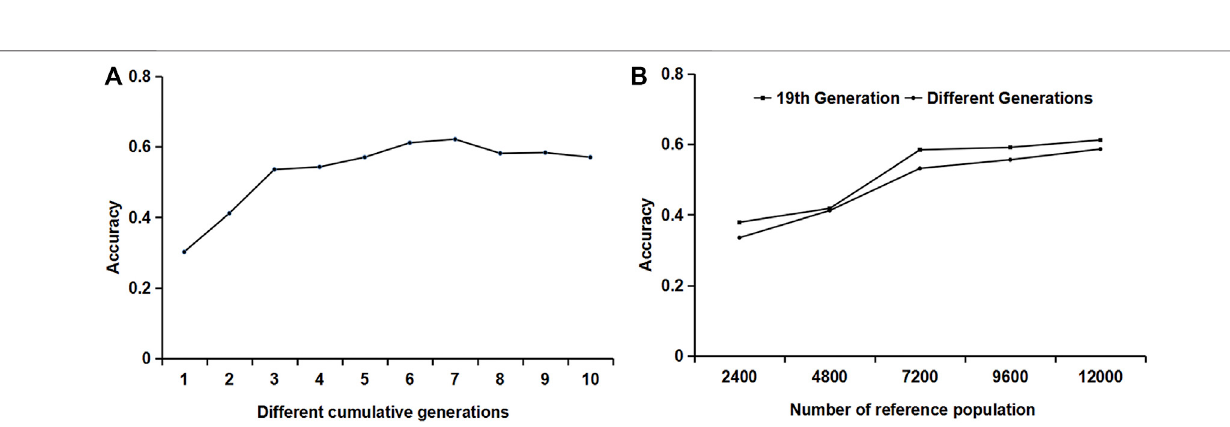
Frontiers in Genetics |